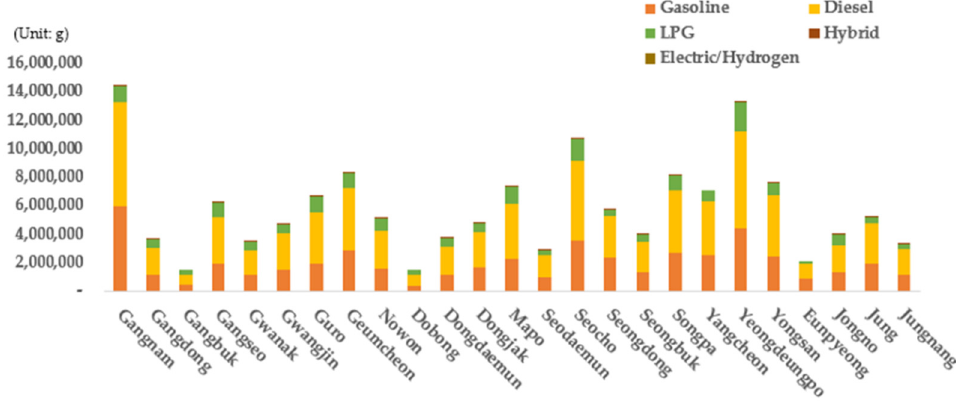
Figure 13. Scenario 1 vehicle emissions by autonomous district ( Gu ) and fuel type.